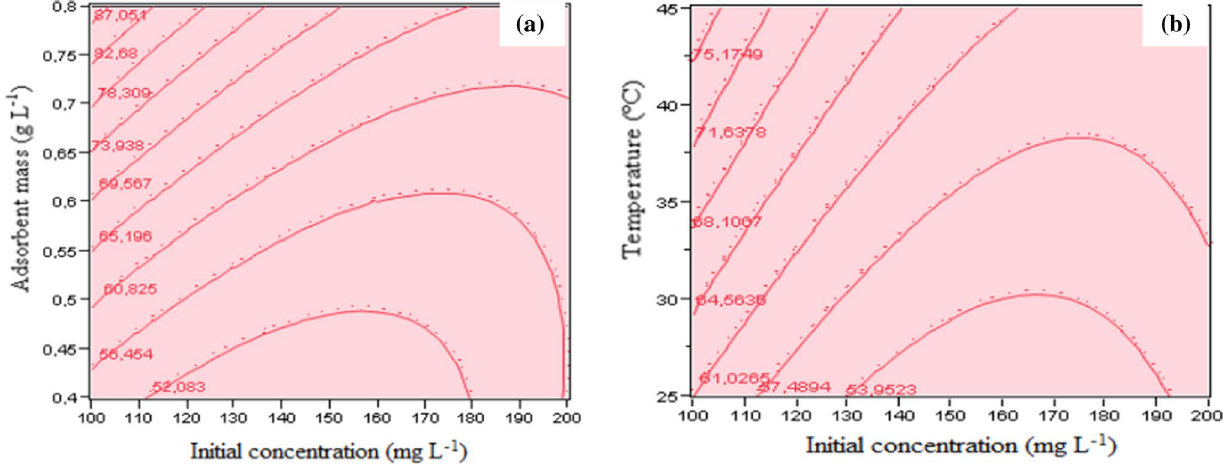
Fig. 6 Contour plots indicating interaction effects of independent variables on variation of removal percentage: a initial concentration–adsorbent mass; b initial